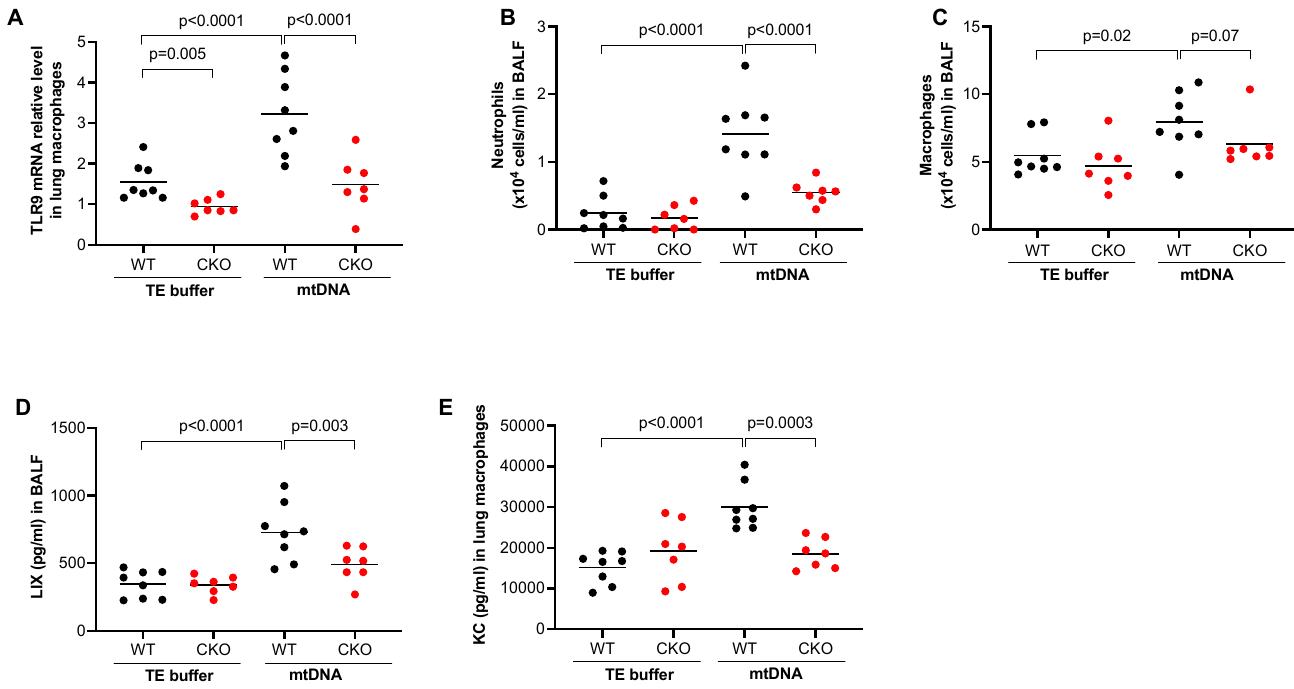
Figure 1. Deficiency of TLR9 in myeloid cells reduced lung inflammatory responses to mtDNA. After receiving the tamoxifen food, Cre – (wild-type, WT) and Cre + (conditional knockout, CKO) TLR9 floxed mice were treated oropharyngeally with mouse lung tissue-derived mtDNA prepared in Tris-EDTA (TE) buffer or TE buffer alone (control) for 24 h to obtain bronchoalveolar lavage fluid (BALF) and lung tissue for isolation of lung macrophages. ( A ) TLR9 mRNA levels as analyzed by qRT-PCR in isolated lung macrophages from WT and TLR9 CKO mice; ( B ) Neutrophil count in BALF; ( C ) Neutrophil chemoattractant LIX levels in BALF; ( D ) Macrophage count in BALF; ( E ) KC measured in the supernatants of macrophages isolated from mice treated with TE or mtDNA. Macrophages were cultured without further stimulation in vitro for 24 h before supernatants were collected for KC measurement. n = 7 to 8 mice per group.